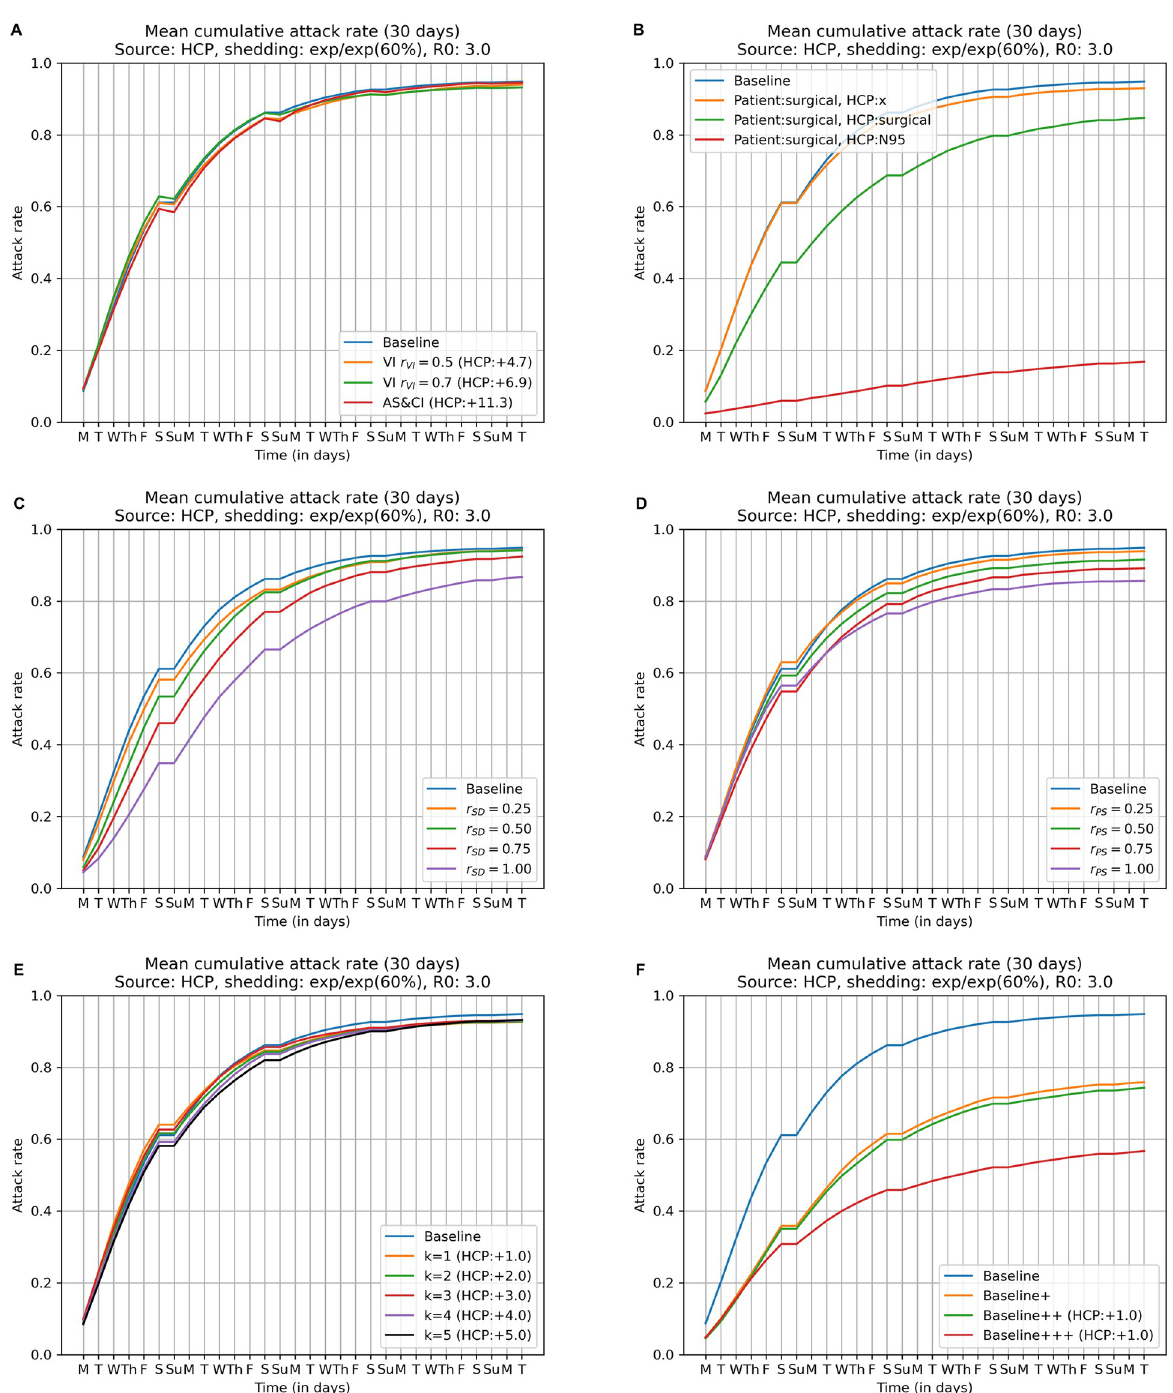
Fig 6. Attack rates for individual NPIs and selected NPIs in combination in Scenario 2 (infection source: HCP), R 0 = 3, exp/exp (60%) . These are the same plots as in Fig 5, except that these are for Scenario 2.